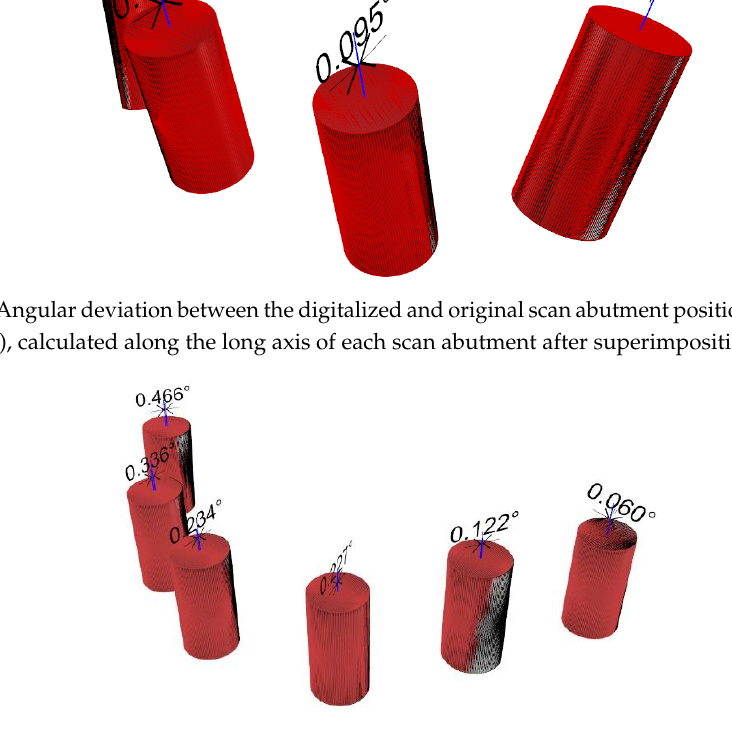
Figure 11. Angular deviation between the digitalized and original scan abutment position (six-implant impression), calculated along the long axis of each scan abutment after superimposition.